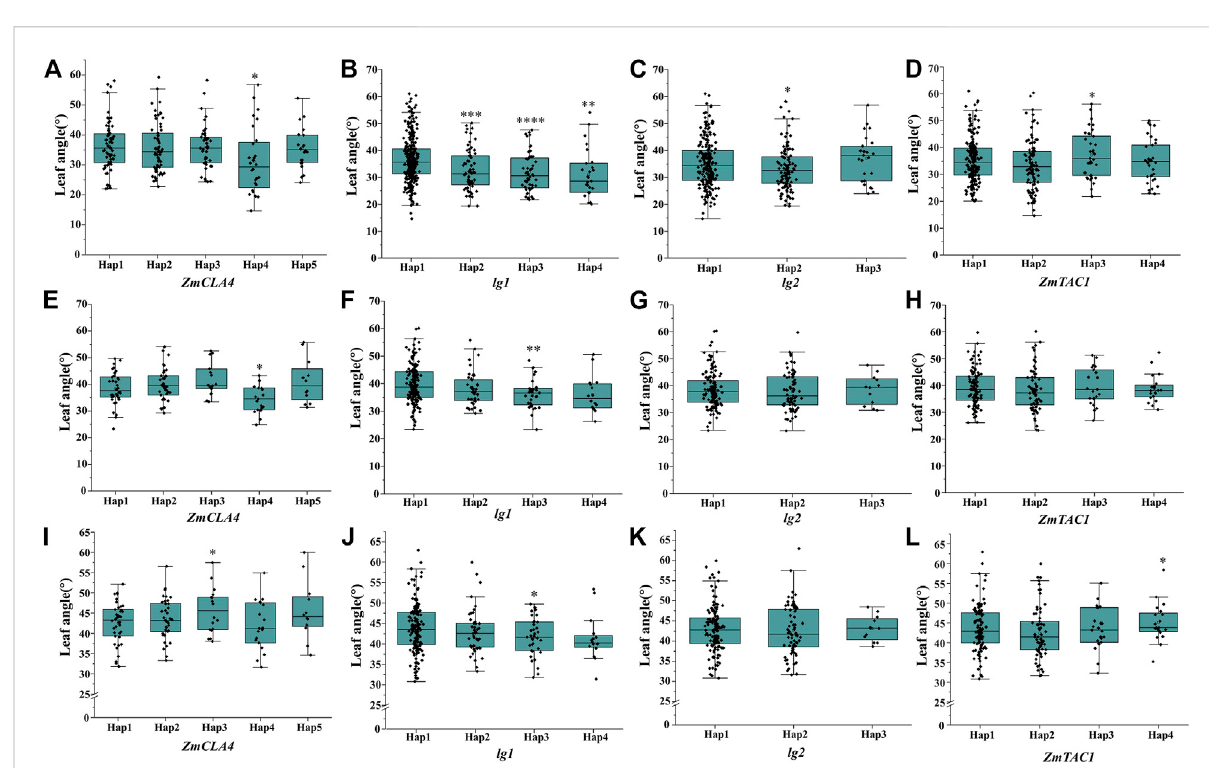
FIGURE 8 Differences of haplotypes in LA-related traits within four cloned genes that regulate maize LA. (A – D) , ULA, of ZmCLA4 , lg1 , lg2 , ZmTAC1 , respectively; (E – H) ,MLA,of ZmCLA4 , lg1 , lg2 , ZmTAC1 ,respectively; (I – L) ,LLA,of ZmCLA4 , lg1 , lg2 , ZmTAC1 ,respectively.Thesigni fi cancelevelwas obtained by comparing others haplotype with hap1, respectively. *: p < 0.05, **: p < 0.01, ***: p < 0.001, ****: p < 0.0001, not marked stands for not signi fi